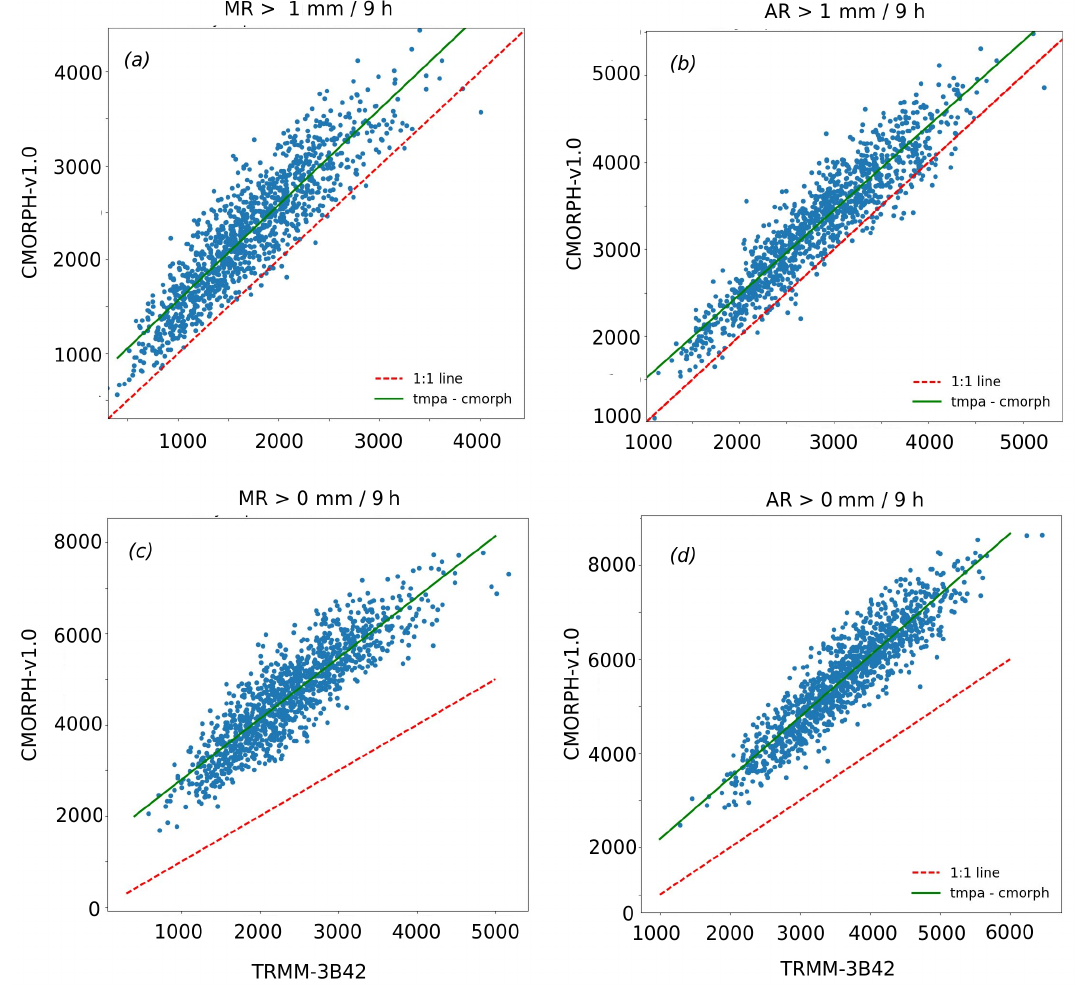
Figure A1. Correspondence of the number of rain pixels per day in TRMM-3B42 and CMORPH-v1.0 with Morning accumulated Rain (MR) or Afternoon accumulated Rain (AR) exceeding a threshold of 1 mm/9 h ( a , b ) or 0 mm/9 h ( c , d